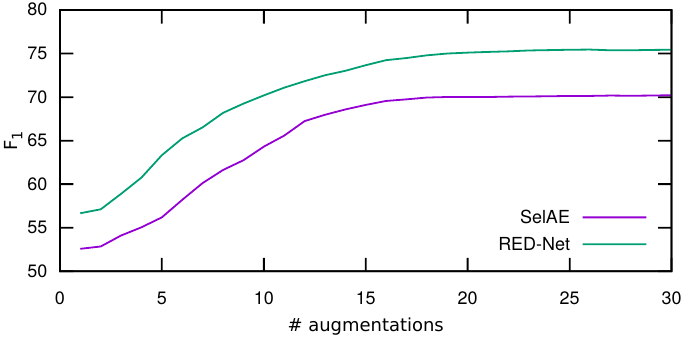
Figure 5. Average results of the data augmentation process. The horizontal axis represents the number of augmentations and the vertical axis the average F 1 (in percentage) obtained for each of the